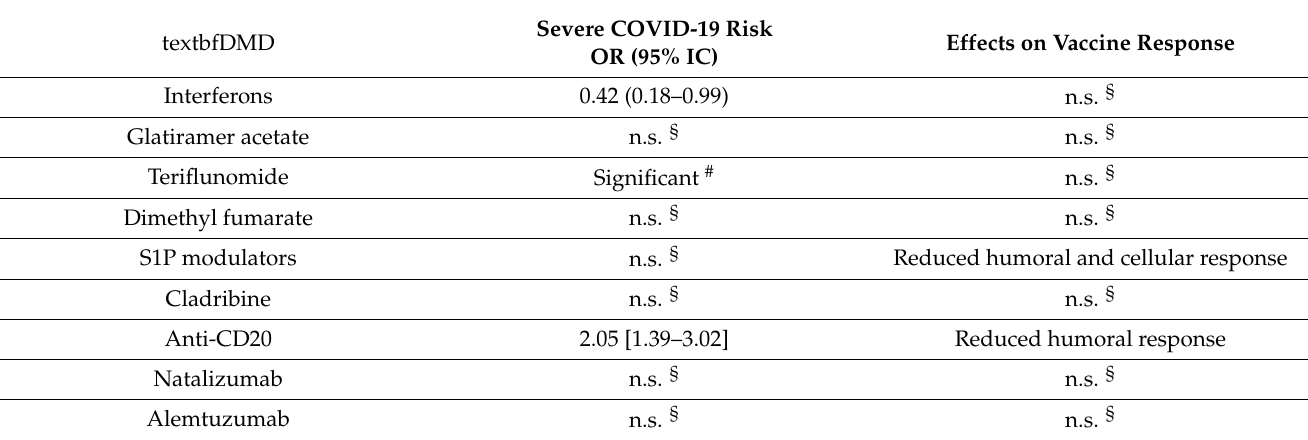
Table 2. DMDs effect on severe COVID-19 risk and vaccine